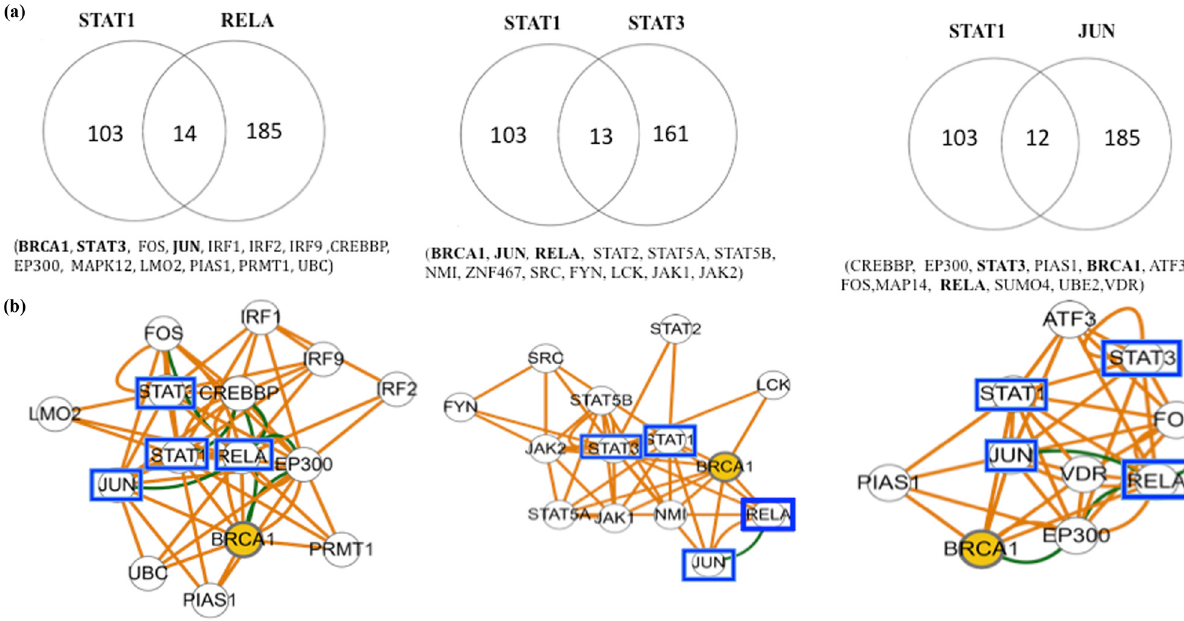
Figure 4: Representation of common protein interaction partners by pairwise comparison of STAT1 vs RELA, STAT1 vs STAT3, and STAT1 vs JUN. ( a ) Venn diagram. ( b ) Network analysis of common protein interaction partners using eSYN program in BIOGRID database. Critical node ( BRCA1 ) is highlighted in yellow color, components of the module are indicated by blue boxes and genetic interactions by green lines.